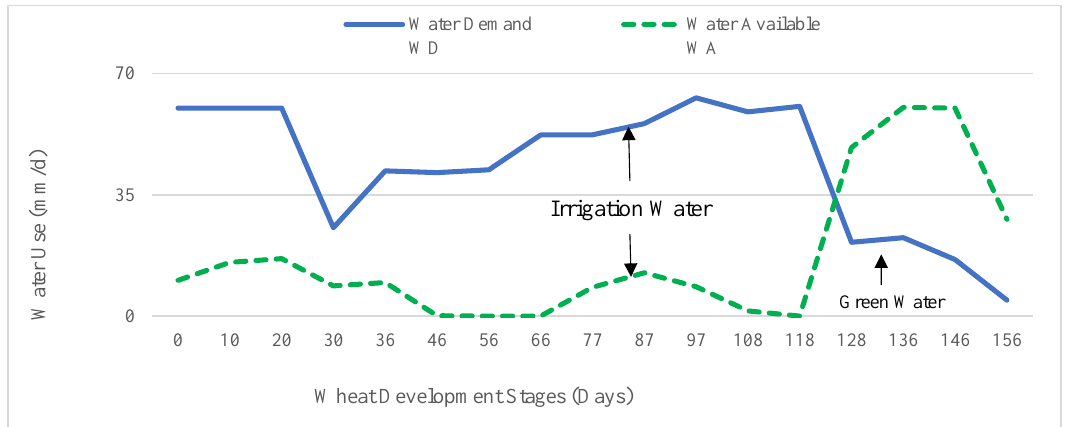
Figure A2. Graphical representation of water demand and water available for pasture .